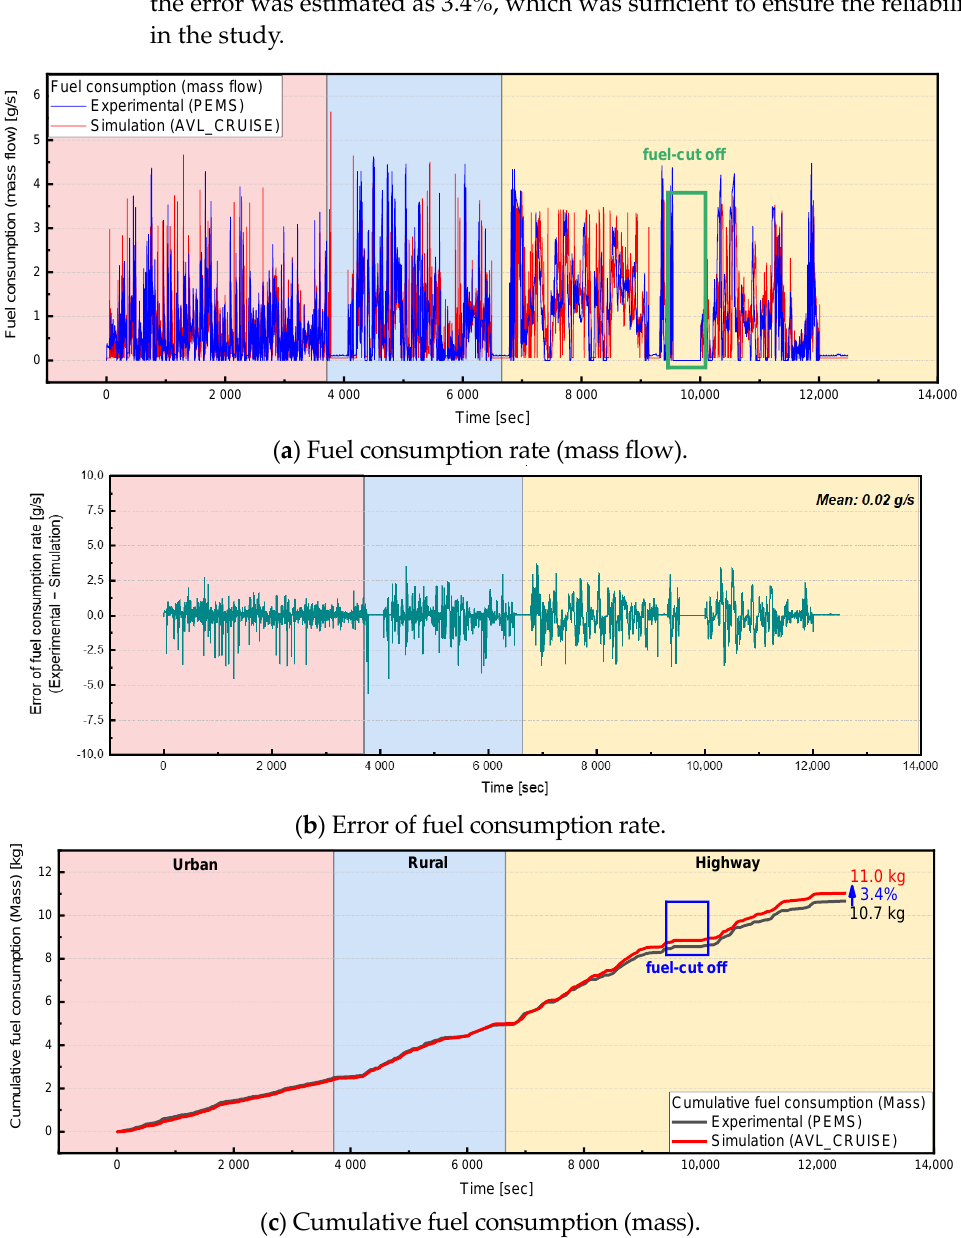
Figure 5. Comparison of fuel efficiency between experiment and simulation results for Route A.